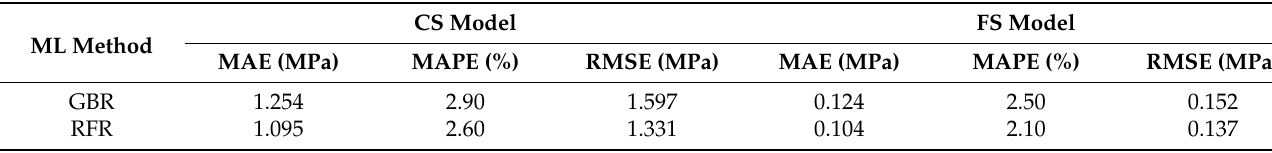
Table 2. Error evaluations of the developed models using statistical checks.